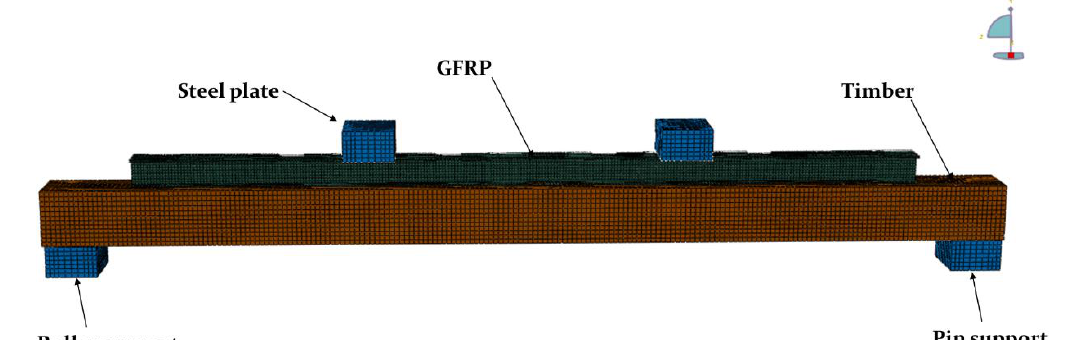
Figure 7. FEM of a timber beam reinforced with a pultruded profile.